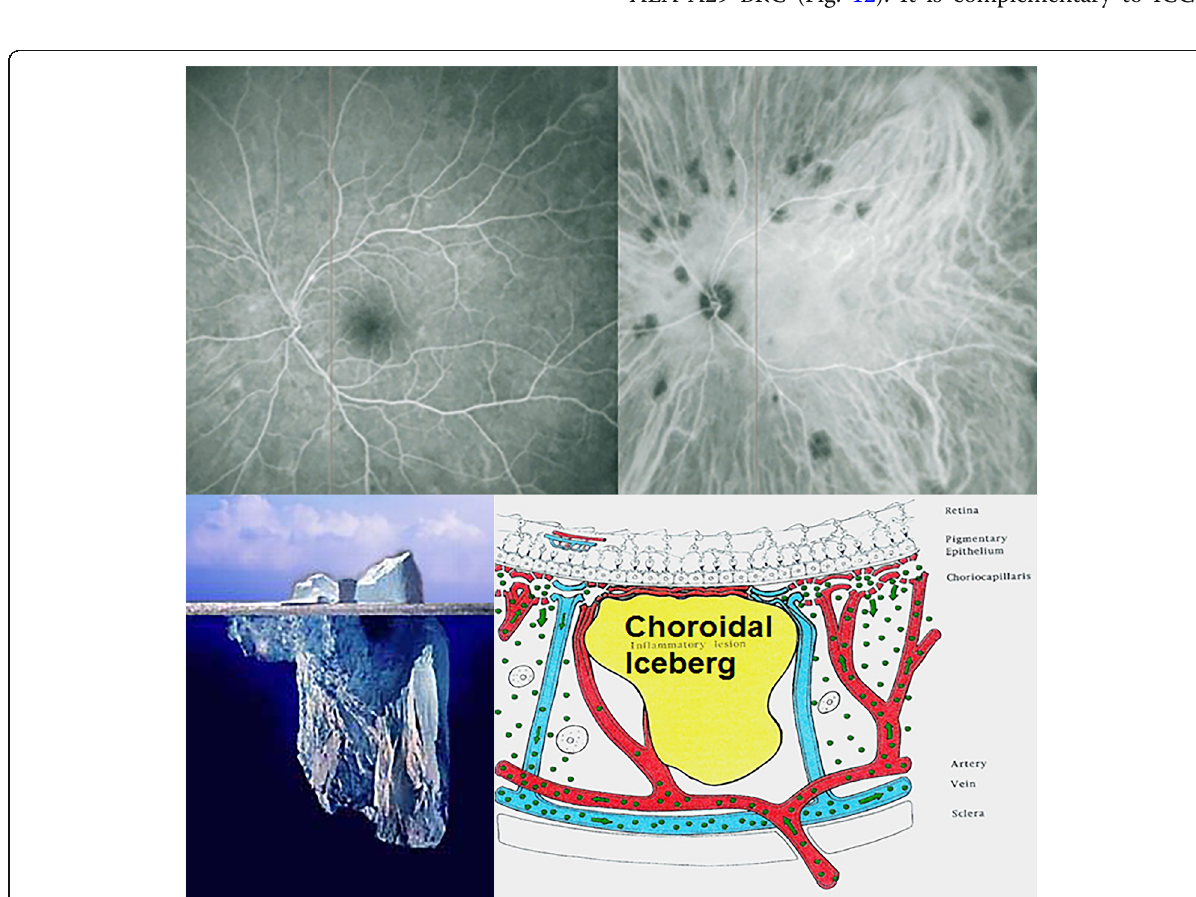
Fig. 8 Indocyanine green angiography (ICGA), type 2 pattern: the iceberg analogy for stromal choroiditis. The bottom two pictures show the analogy between the stromal focus and iceberg. The lesion is not seen on FA (top left), but clearly identified on ICGA appearing hidden below the RPE, appearing as HDDs on ICGA (top